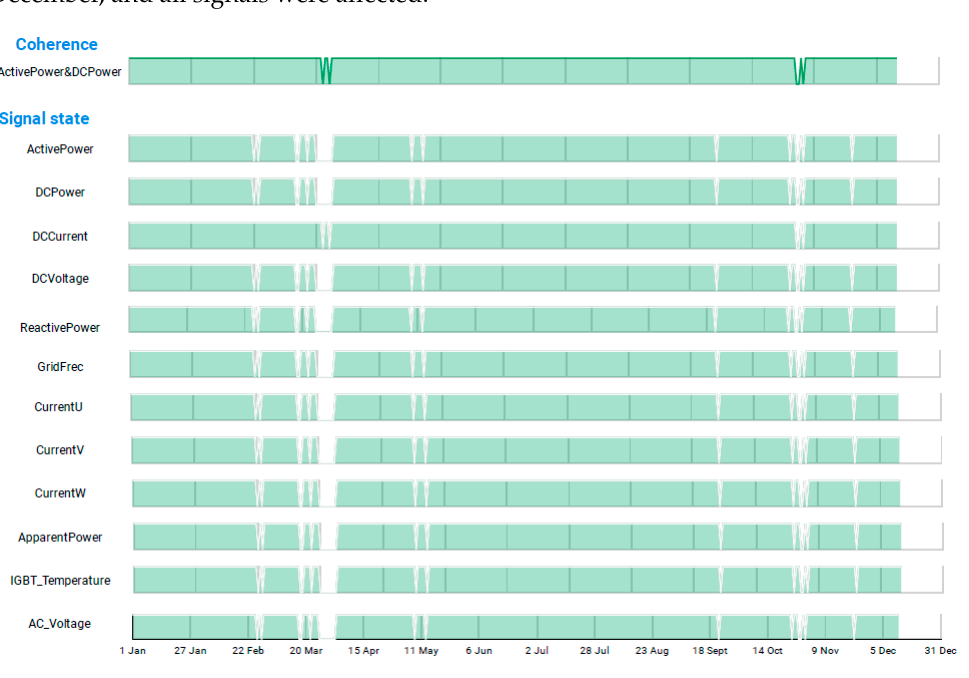
Figure 7. Time series by sensor at the inverter level over the evaluation period (January–December 2021).